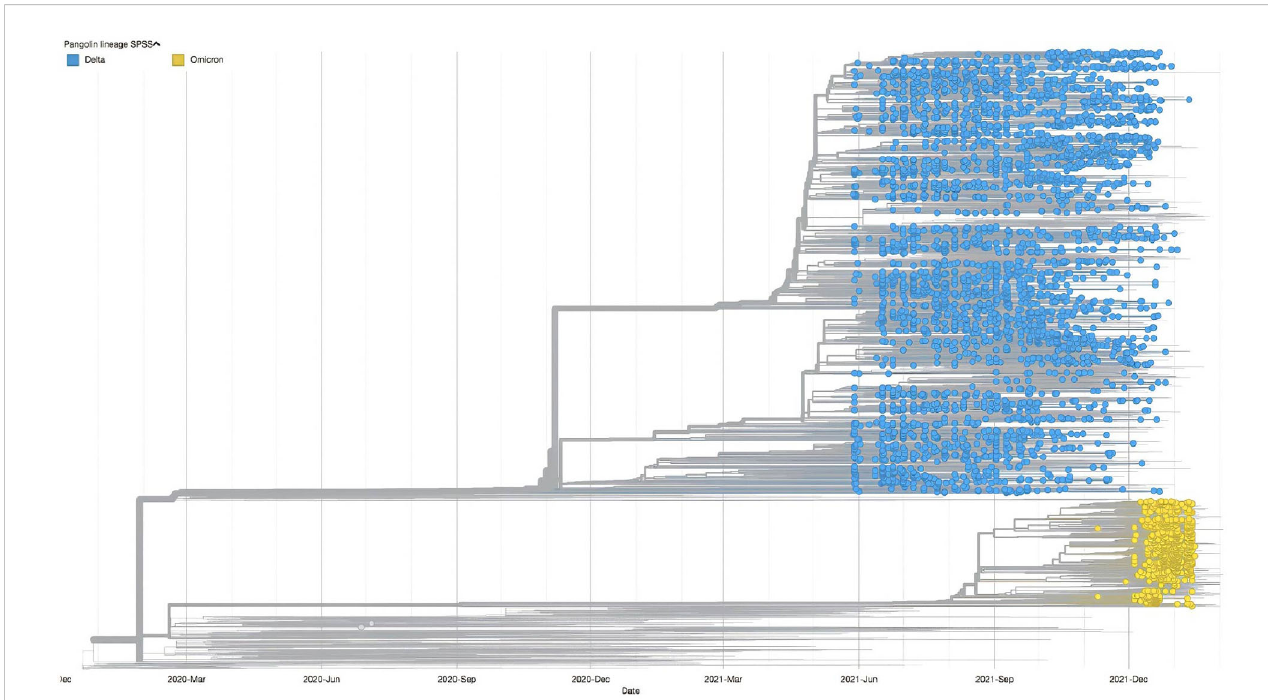
FIGURE 1 Timescale phylogentic tree of the SARS-CoV-2 VOCs (shown as circle) in the UAE from late May 2021 to the end of January 2022, contextualized with the 1,993 most smilar sequences selected from Global Initiative on Sharing Avian In fl uenza Data. VOCs, variants of